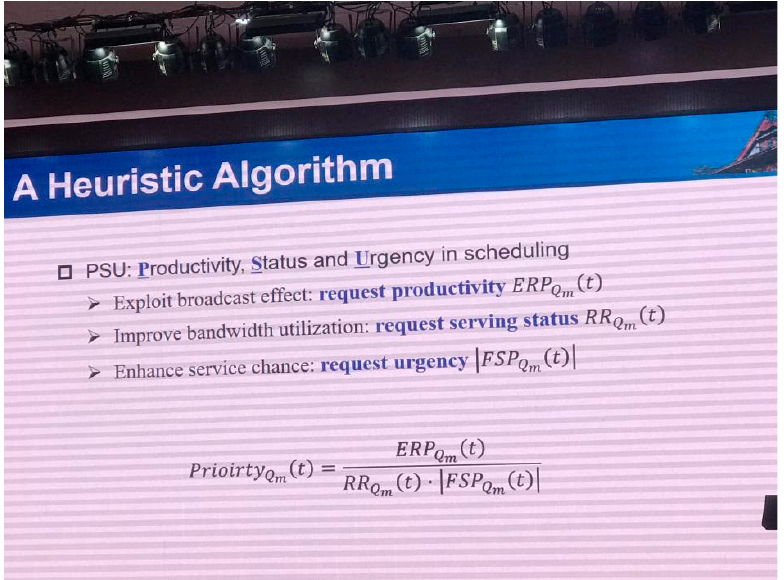
Figure 8. The speech of Professor Liu Kai: A Heuristic Algorithm for Vehicle Scheduling.